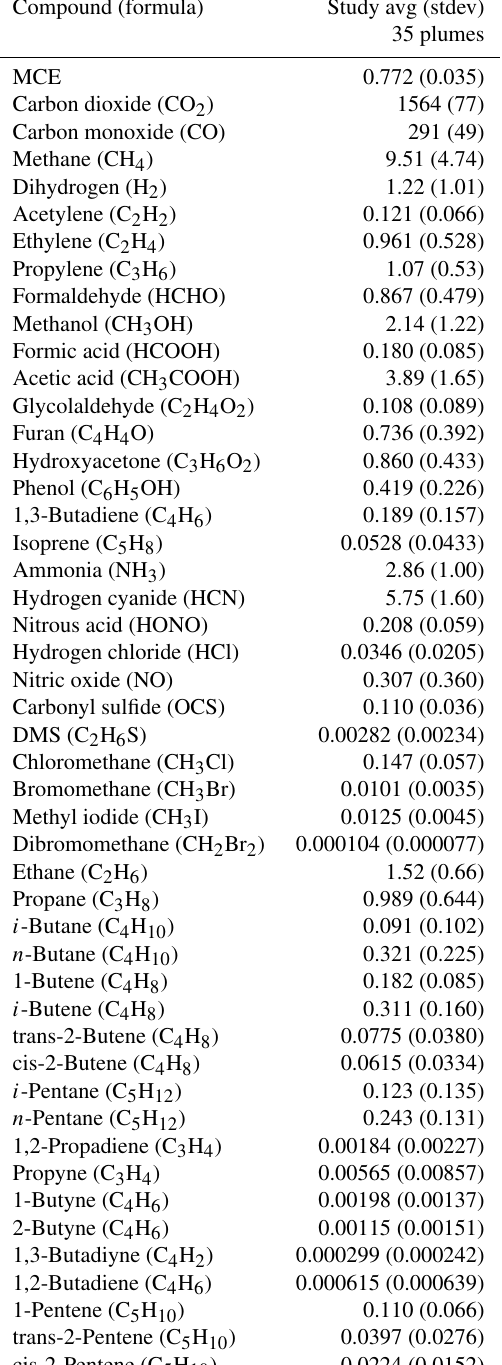
Table 1. Study-average emission factors (gkg − 1 ) and 1 standard deviation (stdev) for trace gases significantly elevated above back- ground in Kalimantan peat fire